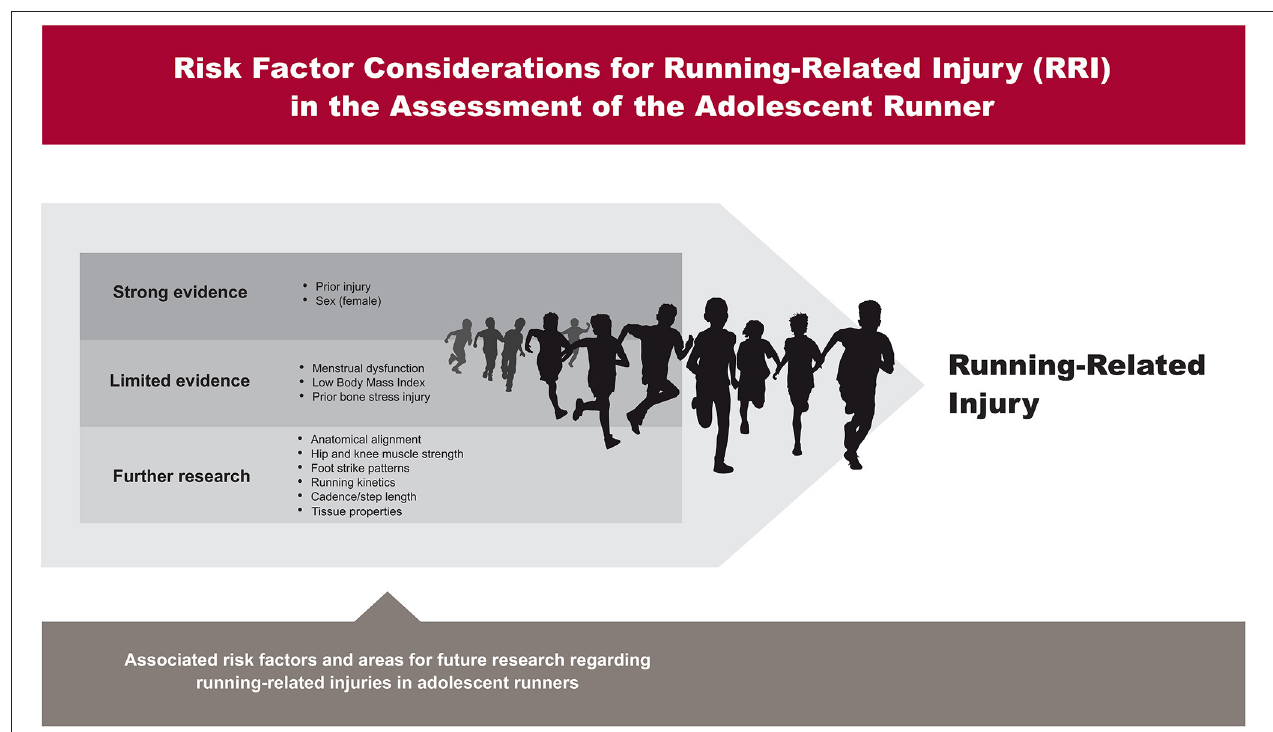
FIGURE 1 | Risk factor considerations for running-related injury (RRI) in the assessment of the adolescent